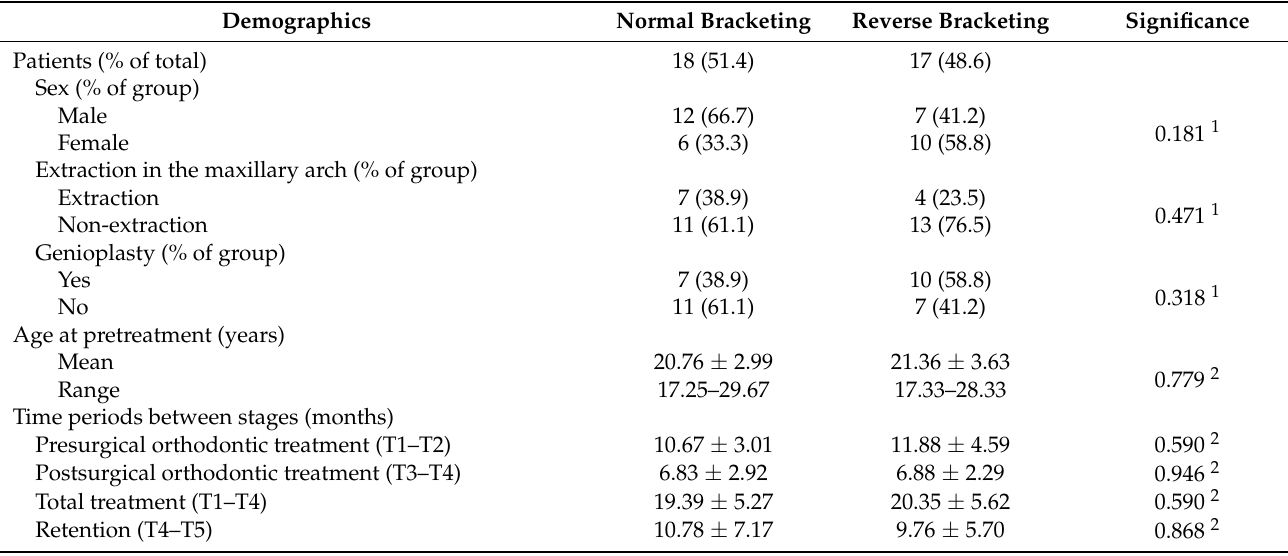
Table 1. Demographic data of patients.